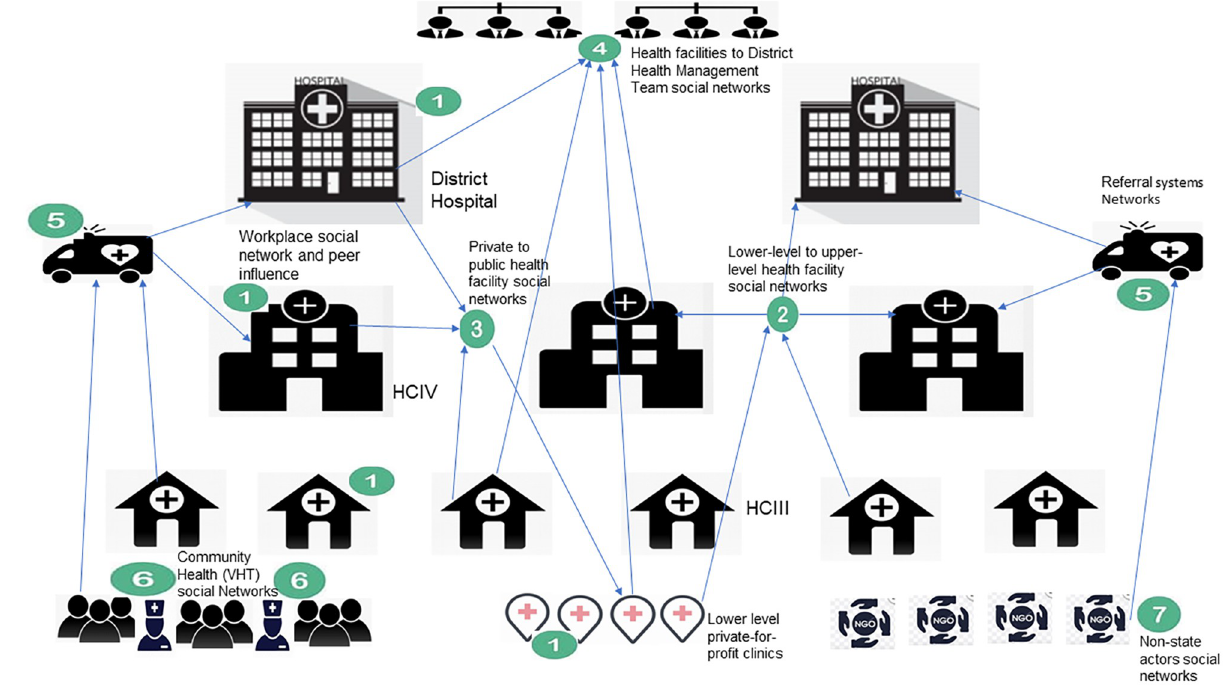
Fig 1. Pictorial flowchart of social network